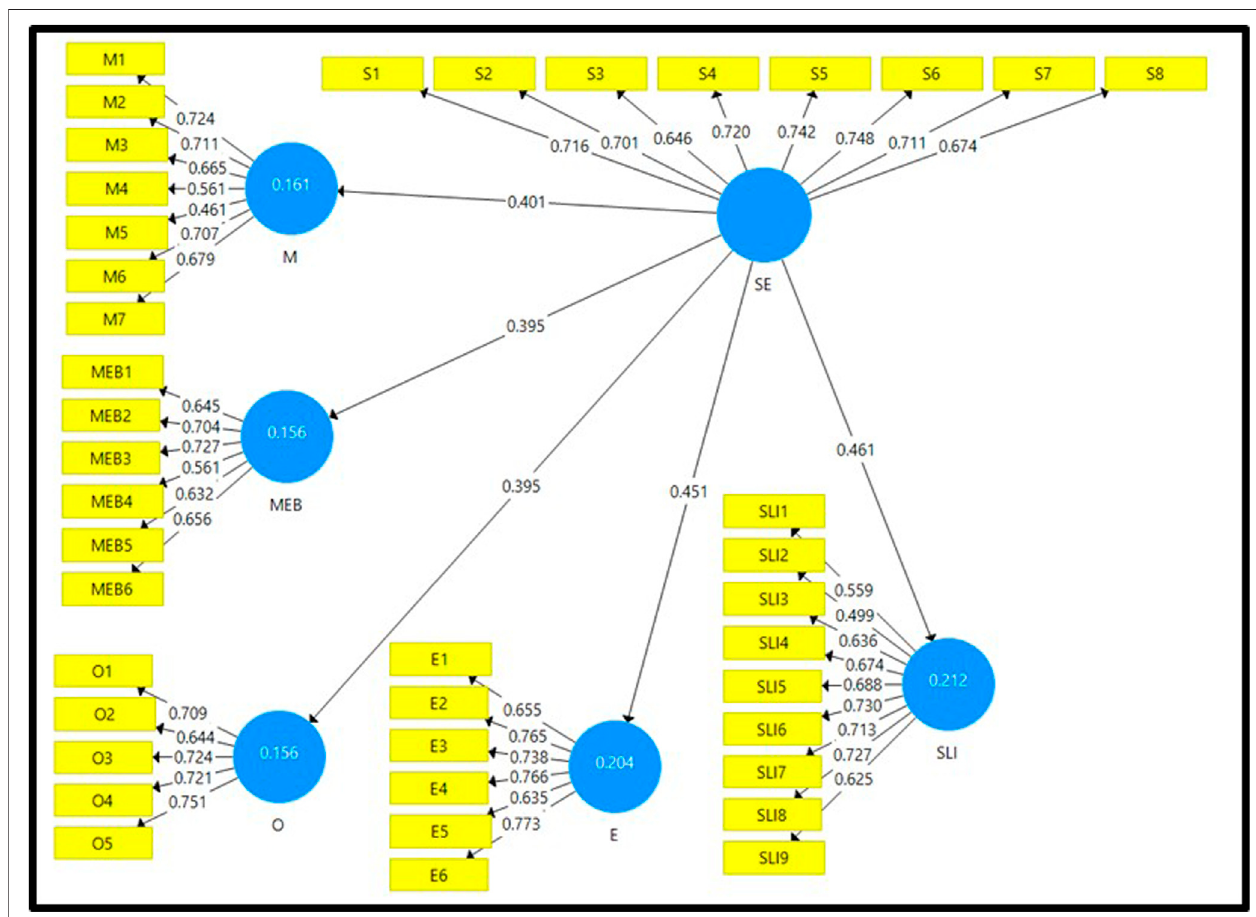
FIGURE 3 | PLS-SEM results (Initial